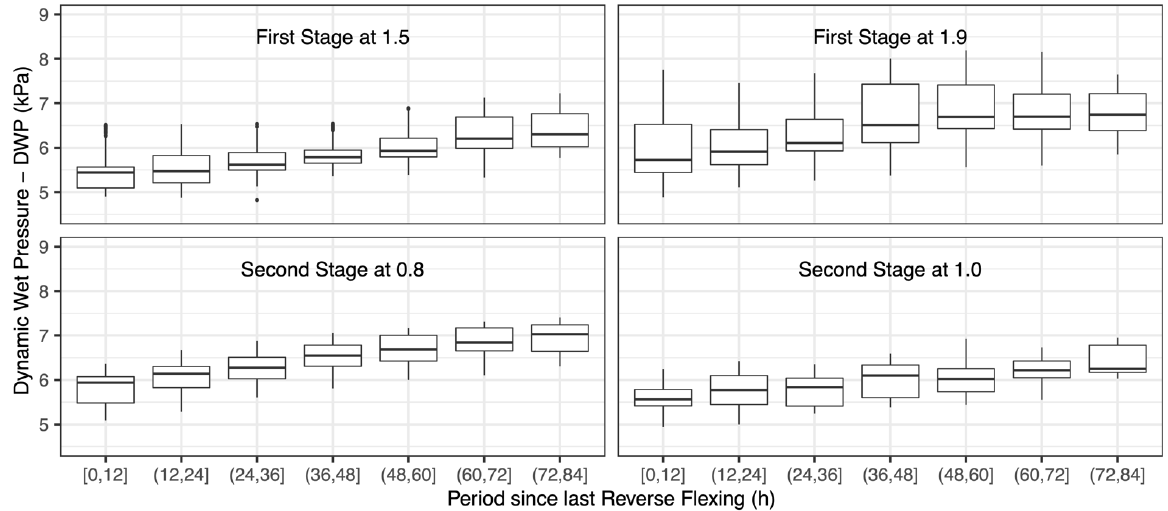
Figure 7. Increase in DWP of disc diffusers since last reverse flexing procedure during operation in activated sludge from first and second stage and at two specific airflow rates (Nm 3 ∙m −3 ∙h −1 ).